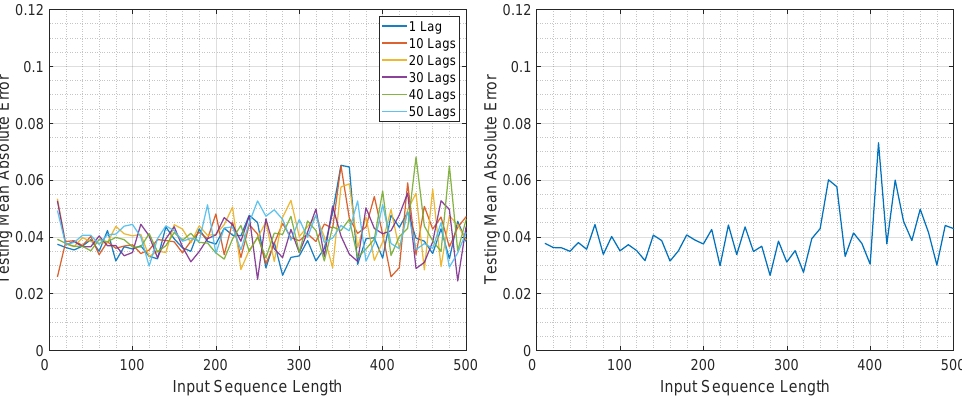
Figure 17. Illustration of the testing mean absolute error value for Experiment 1, LSTMTF ( left ) and VLSTM ( right ), using a many-to-one prediction mode.